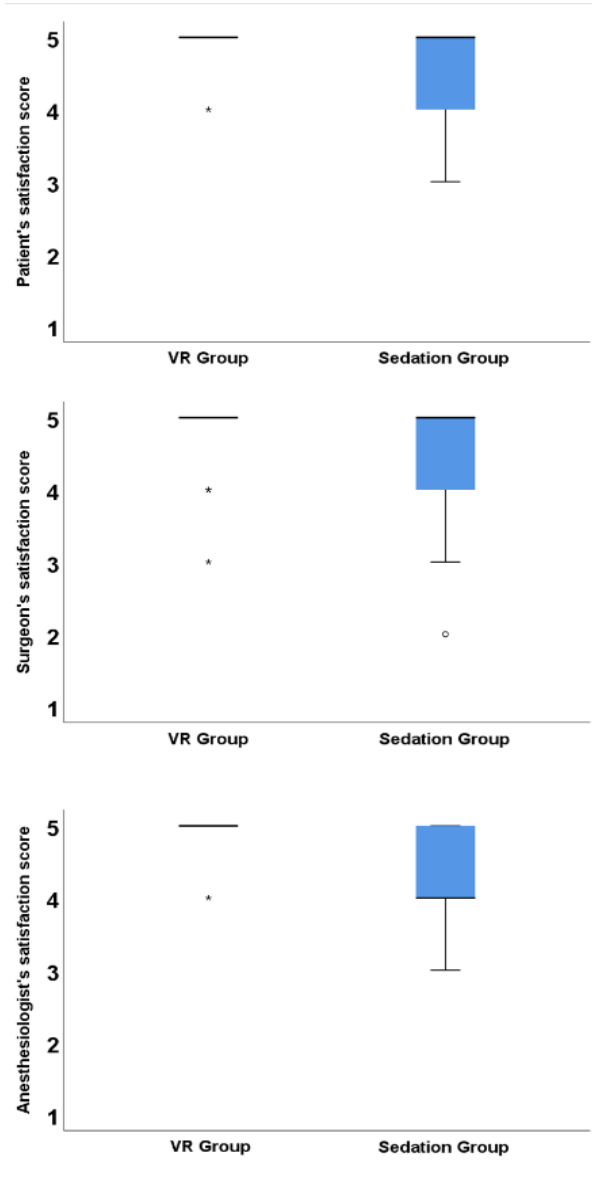
Figure 2. Box-and-whisker plots of the satisfaction scores of patients, surgeons, and anesthesiologists. Thick horizontal bars, boxes, and error bars represent the median, 25th, 75th, 10th and 90th percentile. VR group = Virtual Reality group, 1 = extremely dissatisfied, 2 = dissatisfied, 3 = undecided, 4 = satisfied, 5 = extremely satisfied, ◦ means outlier and * means extreme outlier. Extreme outlier is determined when outliers is located distal to 1.5 × interquartile range from 25 or 75 percentile. Table 3. Sedation-related